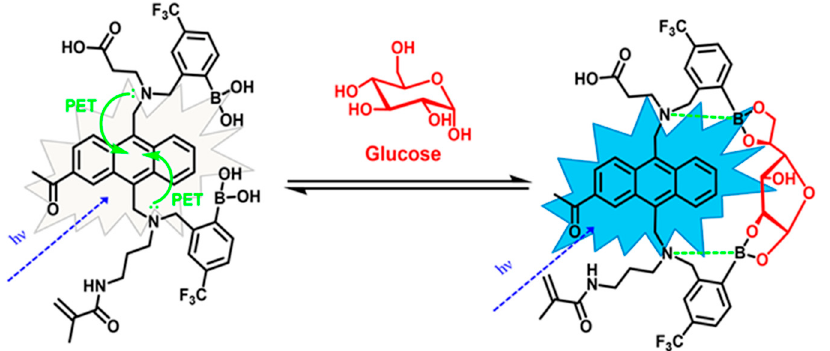
Figure 4. Glucose-dependent fluorescence change for AcTDA. Quenched fluorescence of AcTDA was recovered after formation of AcTDA–glucose because photoinduced electron transfer was blocked by the B-N bond pair. where F is the measured fluorescence intensity, F 0 is the fluorescence intensity of free AcTDA, and F max is the saturated fluorescence intensity of the AcTDA–glucose complex.